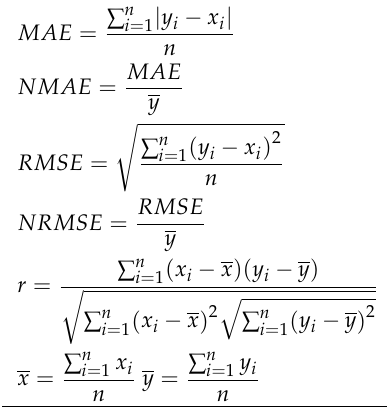
Table 3. Statistical indicators used to evaluate reliability of ANN modeling. MAE—mean absolute error; NMAE—normalized MAE; RMSE—root-mean-square error; NRMSE—normalized